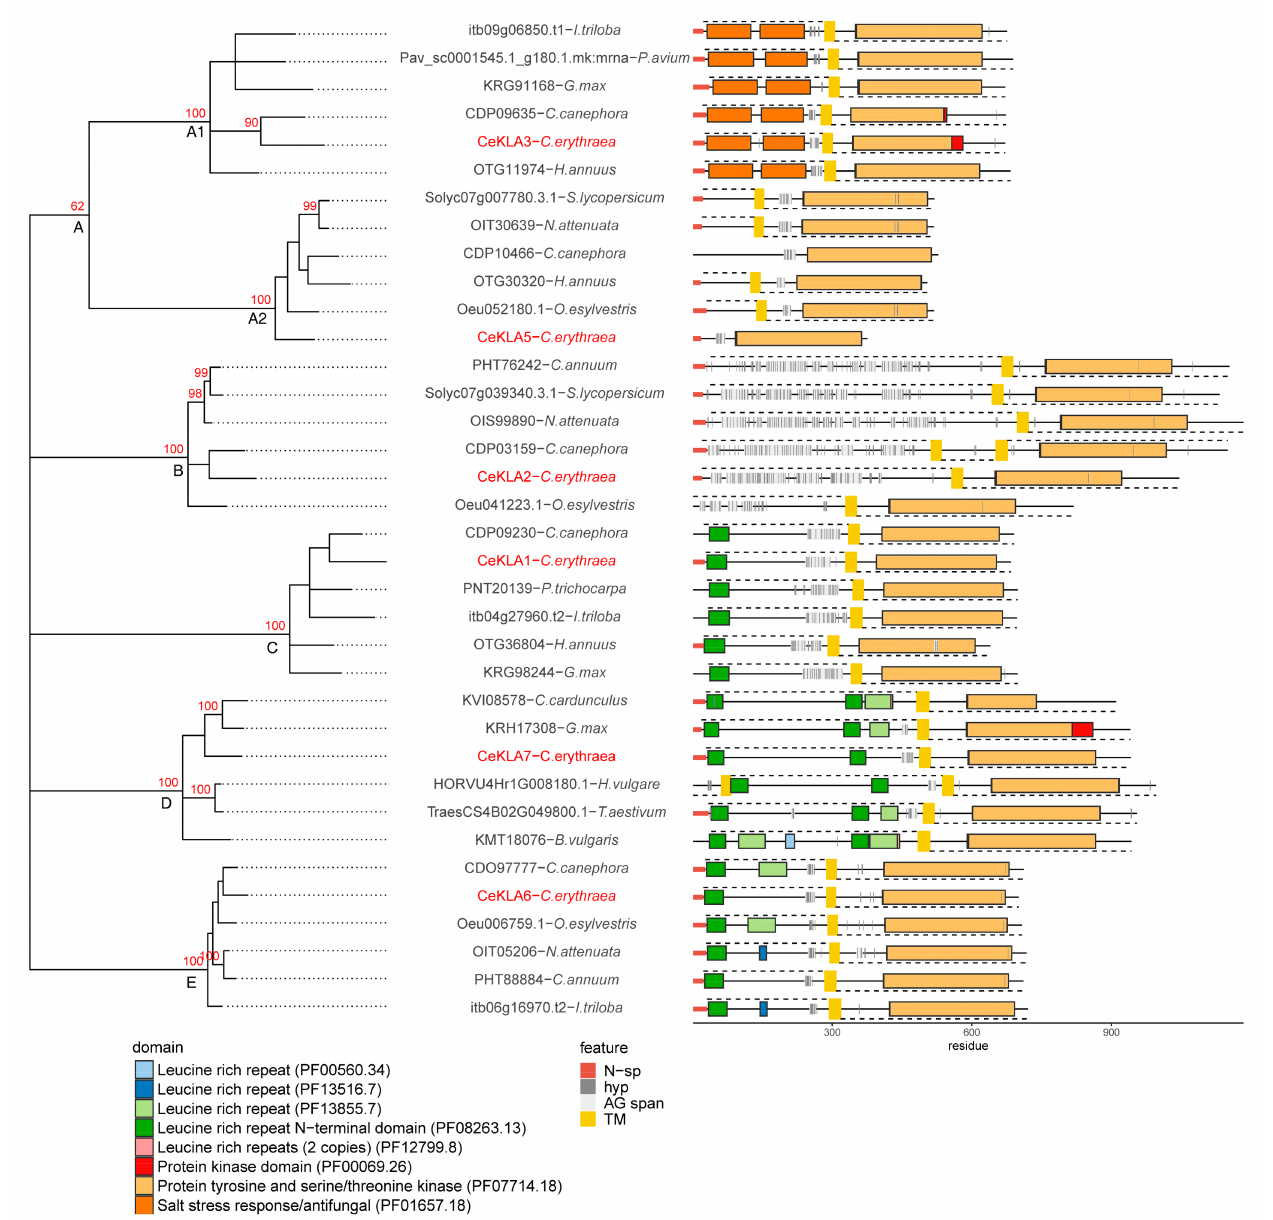
Figure 4. Phylogenetic relationship of six C. erythraea KLA protein sequences with homologues from other plant species. The phylogenetic tree represents an unrooted maximum likelihood tree constructed using the JTT amino acid model. Cluster stability was evaluated using 100 replicates of nonparametric bootstrap. Clusters with ≥ 80/100 bootstrap support are indicated with a red number. Clusters with ≤ 50/100 bootstrap support were collapsed into multichotomies. Intermediate (50–80) bootstrap support is indicated on major clusters. Protein schematic diagrams were constructed using ragp R package: N-sp as predicted by Signalp4.1 are represented with red segments on the N-terminus; domains as predicted with hmmscan 3.3.2 and using Pfam-A33 database are represented according to the color legend; transmembrane domains (TM) as predicted using Phobius1.01 are represented using yellow rectangles. Proteins with predicted TM extracellular regions are indicated with dashed lines above the protein diagram, while the intracellular regions are indicated with dashed lines below the protein diagrams; hydroxyprolines as predicted with ragp 0.32 are indicated with bar-code-like vertical black lines, while AG motif spans (at least three AG motifs, no more than 10 amino acids apart) are indicated with light grey